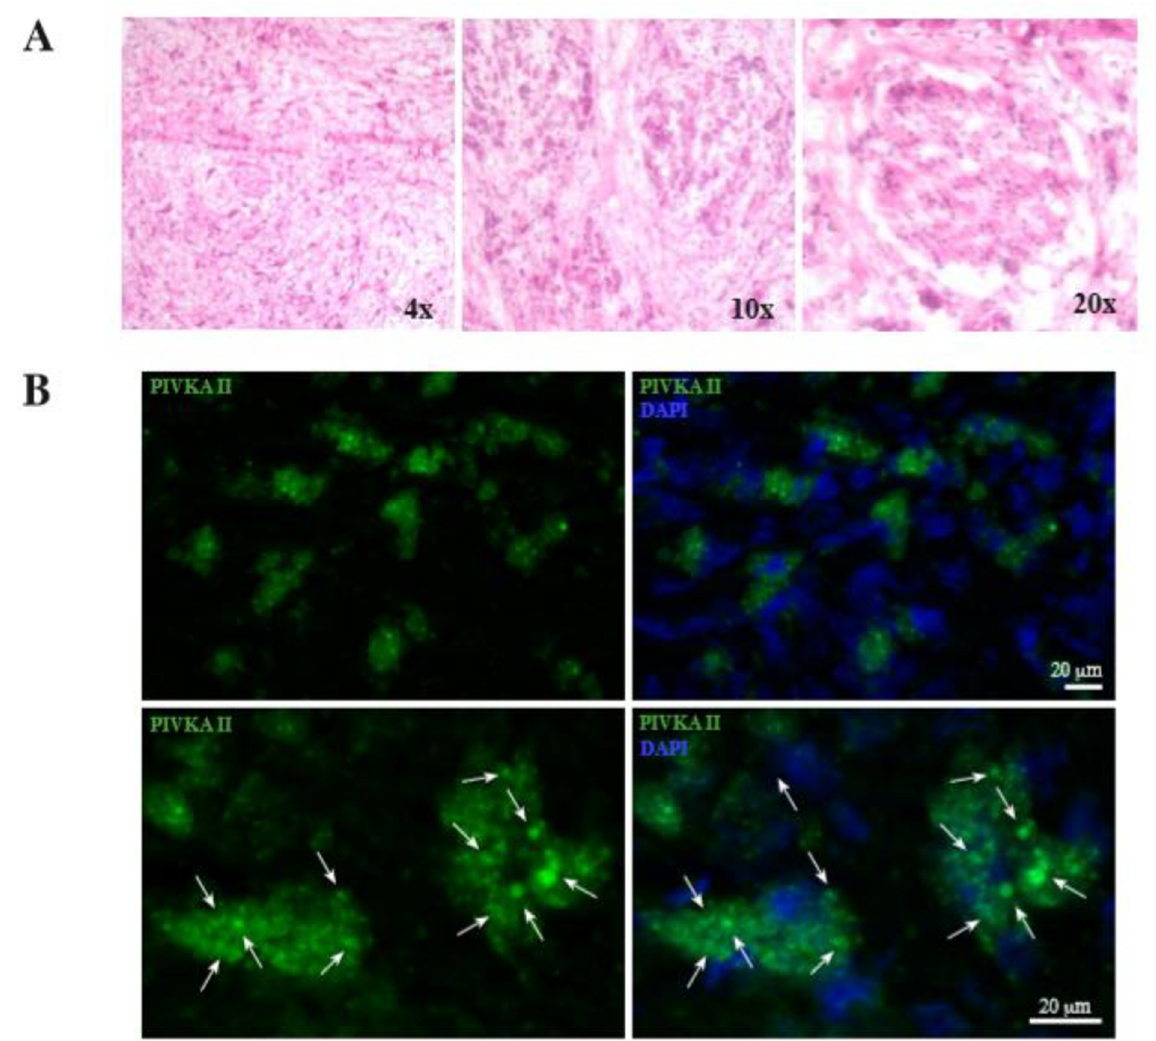
Fig 1. PIVKA II espression in PDAC tissue slides. A) H&E staining of PDAC sections; the tissue is intact and composed entirely of tumor cells, pleomorphic and with altered cytoplasmic nucleus ratio. B) IF analysis of the PIVKA II of PDAC tissue. Several cells are marked, and the signal appears cytoplasmatic and dotted, mainly distributed in the perinuclear area. DAPI was used to highlight cell nucleus. Arrowheads indicate cytoplasmic dots. Bar: 20 μ m. H&E = Hematoxylin and eosin PDAC = Pancreatic adenocarcinoma IF = immunofluorescence DAPI = 4 0